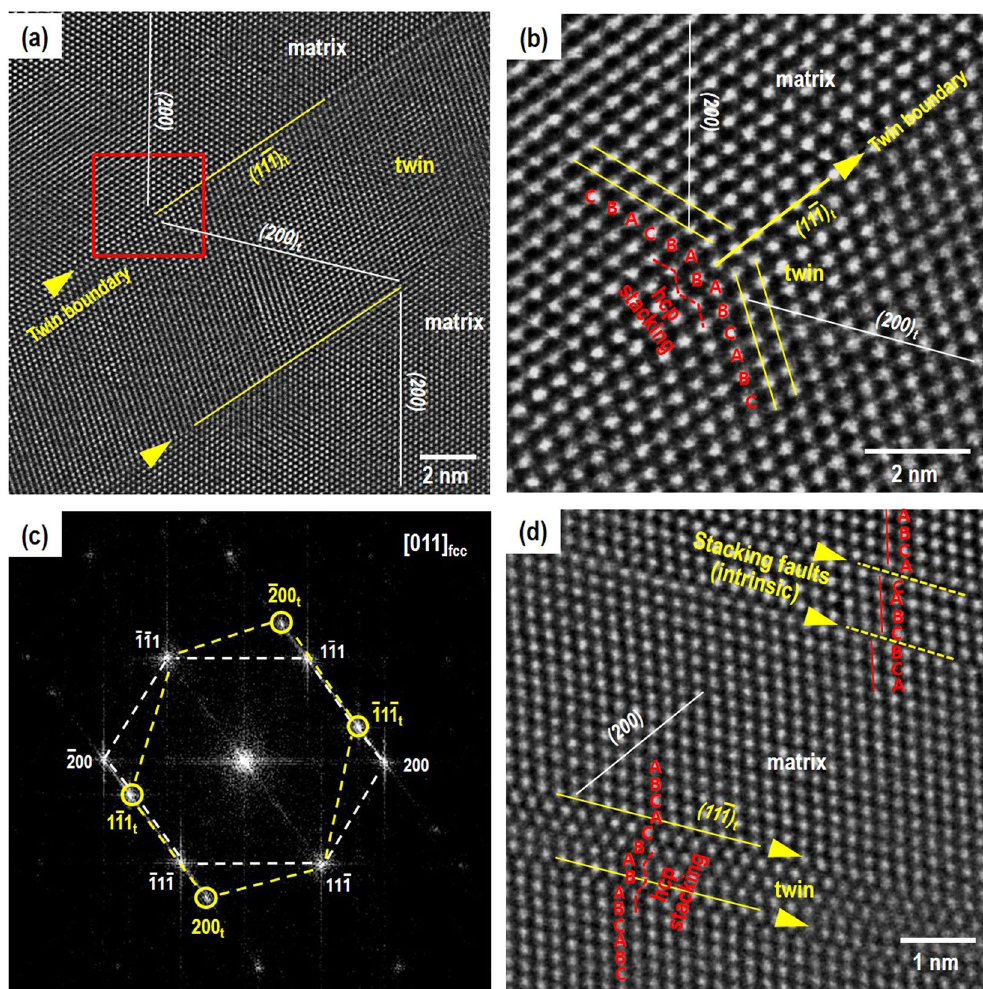
Figure 7. High-resolution HAADF-STEM images along the < 101 > zone axis of the AM CrCoNi specimen ( a , b ) deformed ( ε = 58%) with LSR (2 × 10 − 5 s − 1 ), ( c ) Fast Fourier transformation (FFT) of the TEM image of ( b , d ) deformed ( ε = 47%) with HSR (2 × 10 − 3 s − 1